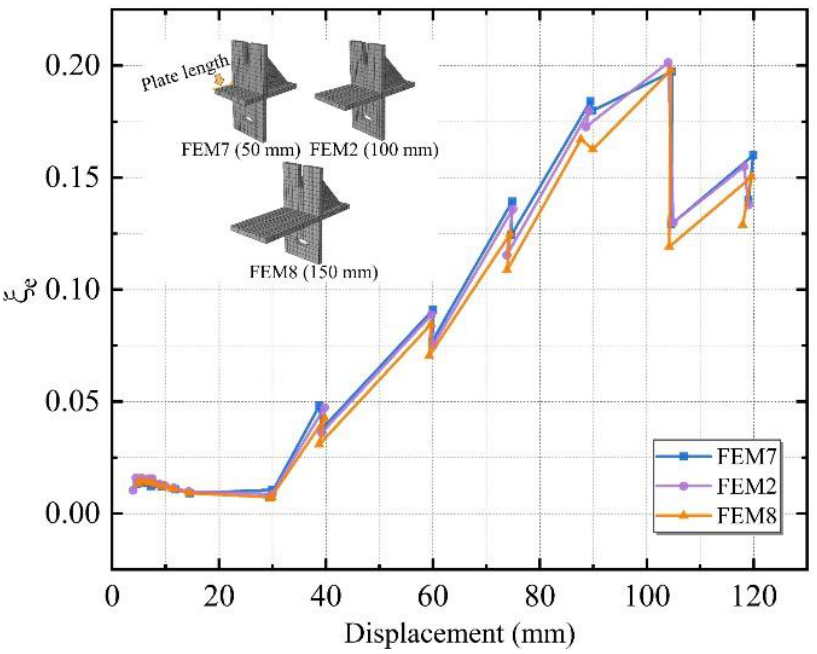
Figure 21. The equivalent viscous damp ratio for specimens with different plate lengths.